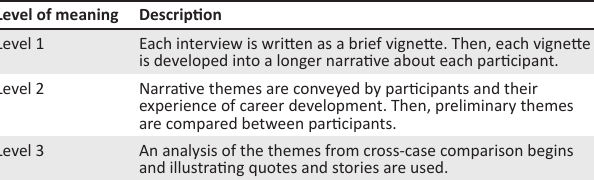
TABLE 2: Data analysis procedure. Level of meaning Description Level 1 Level 2 Level